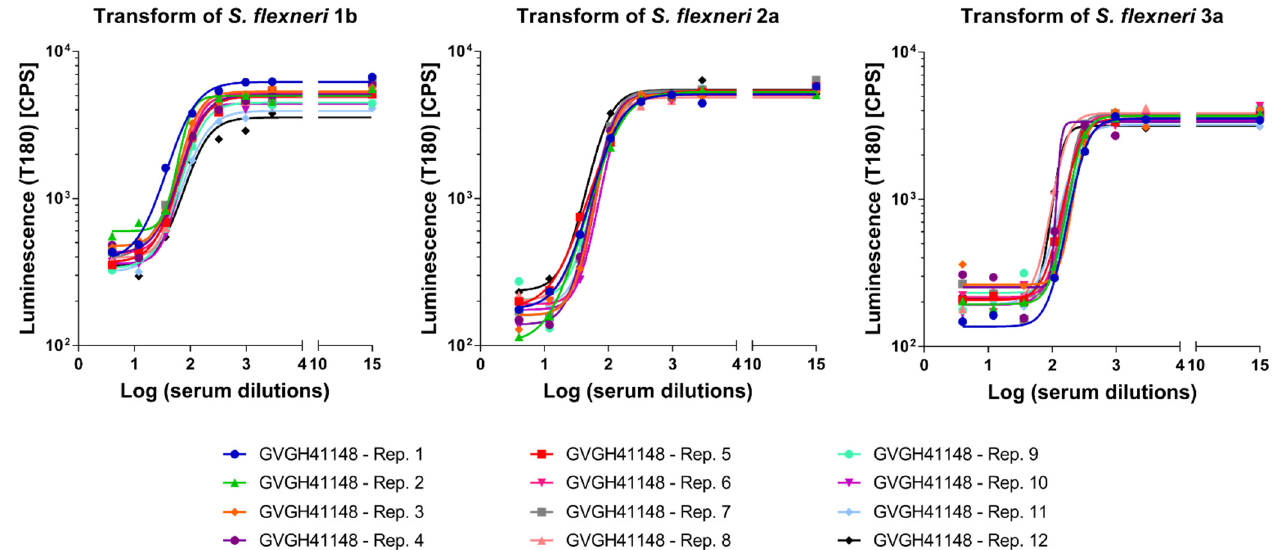
Figure 5. Luminescence vs. Log serum dilution of samples tested to assess LoD and LoQ. Symbols represent single measurements. Solid lines represent the fitted 4 parameters curves to single measurements data for each sample assayed against the three S. flexneri serotypes.